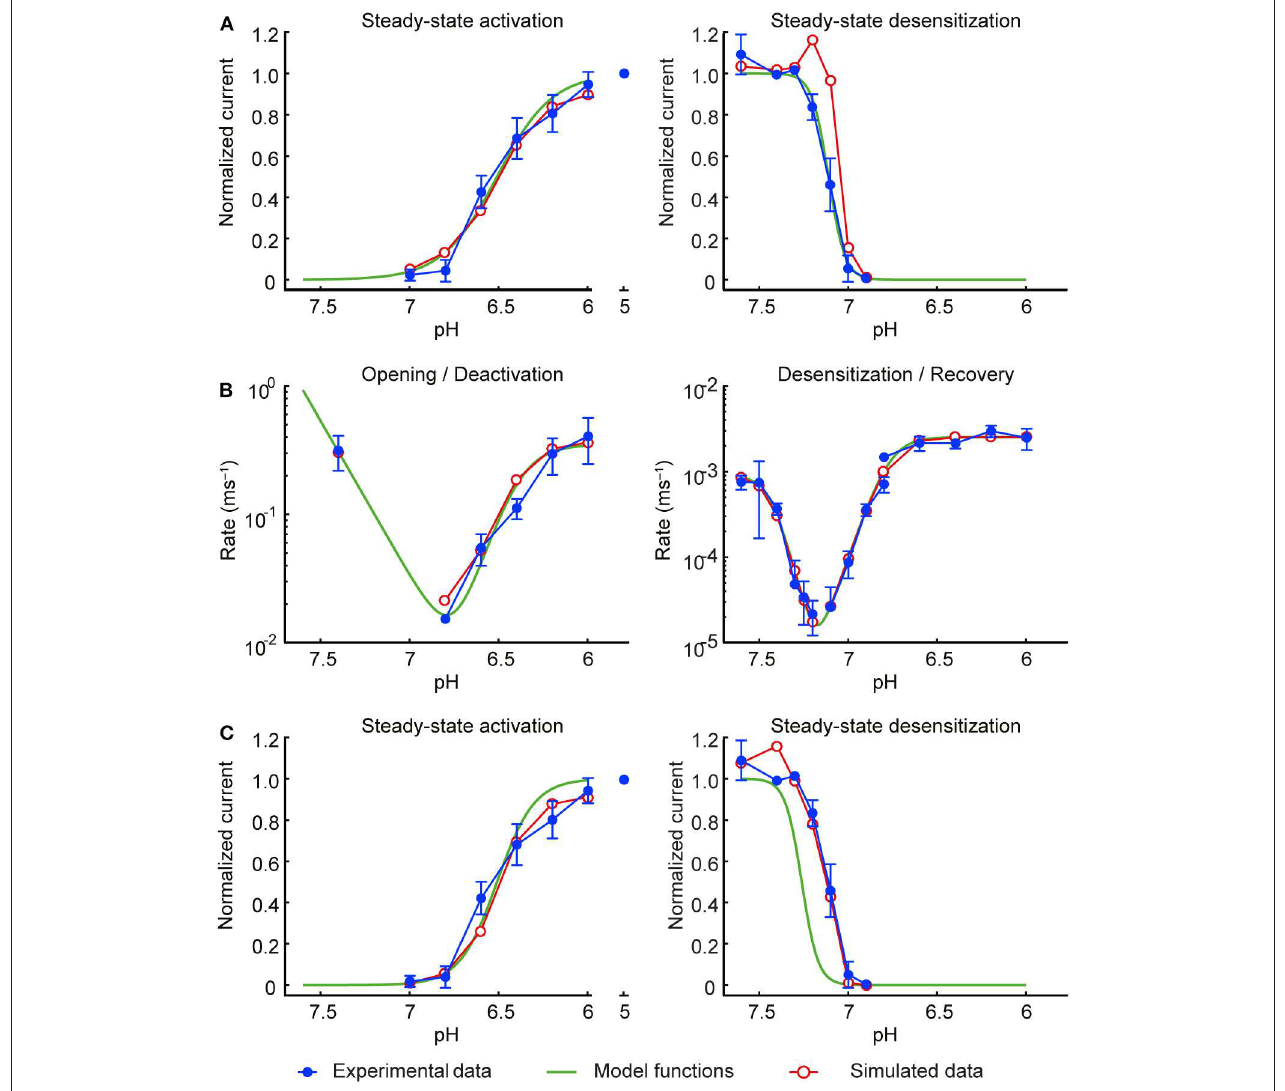
FIGURE 2 | Development of the model of the ASIC1a current. Experimental data are shown in blue, the initial functions a ∞ and s ∞ fit to the experimental data are shown in green and the corresponding simulated data in red. Currents were measured from CHO cells stably expressing ASIC1a, in the whole-cell mode ( A,C ; B , right panel, desensitization from the closed state and recovery from desensitization) or from excised outside-out patches [ B , left panel (opening and deactivation) and right panel, desensitization from the open state]. (A) Steady-state activation (left) and steady-state desensitization (SSD, right). For measuring steady-state activation curves, cells were exposed to the conditioning pH 7.4, and the solution was changed every 50s for 5s to an acidic test pH to activate ASICs, n = 8–10. To determine the SSD pH dependence, channels were activated by a first exposure to pH 6 for 8s (I 1 ), which was followed by a 40-s exposure to pH 7.4, a 60-s exposure to the test conditioning pH and a 8-s exposure to pH 6 (I 2 ). After this, channels were exposed during 42s to pH 7.4, and subsequently a new cycle, with a different test conditioning pH was started. The I 2 /I 1 ratio was then plotted as a function of the conditioning pH, n = 4–9. (B) Rates of opening and deactivation (left) and desensitization and recovery from desensitization (right). Experimental data are as in Figure 1F ; protocols as described in the legend of Figure 1 . (C) Same as in (A) , but using the modified functions a ∞ and s ∞ of the final model. In all simulations, the model was subjected to the same pH protocols and its output to the same analyses as in the experiments.